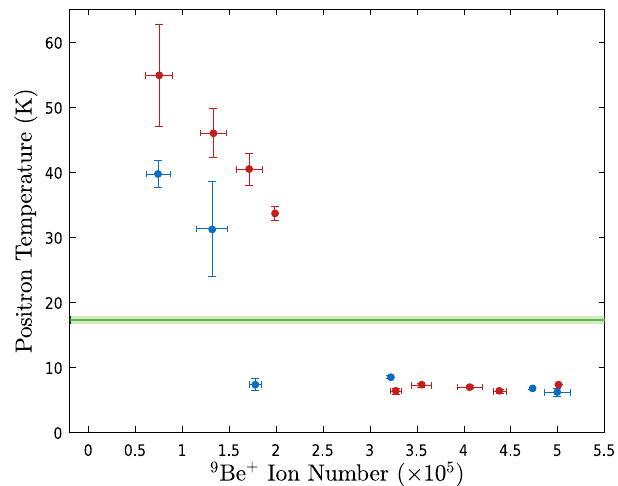
Fig. 3 Positron temperature as a function of the number of Be + ions used for sympathetic cooling. The ion number has been binned with the horizontal error bars representing the standard deviation of the mean ion number within each bin. The vertical error bars correspond to the standard error on the mean temperature within each bin. The ion number was varied by changing the number of ablation pulses used for loading, and also by splitting the ion plasma using axial potential manipulations. We used 1.4 × 10 6 positrons (blue points) and 2.6 × 10 6 positrons (red points) with initial densities of 1 × 10 8 and 3 × 10 8 cm − 3 , respectively. The cooling laser frequency was swept from an initial detuning of − 129 Γ to a fi nal detuning of − 7 Γ in ~40 s for sympathetic cooling of the positrons. The positron temperature for 2.6 × 10 6 positrons with no ions present (green line) is shown for comparison. The shading around this line indicates the standard error. Note that the positron-only temperature for 1.4 × 10 6 positrons is consistent with this